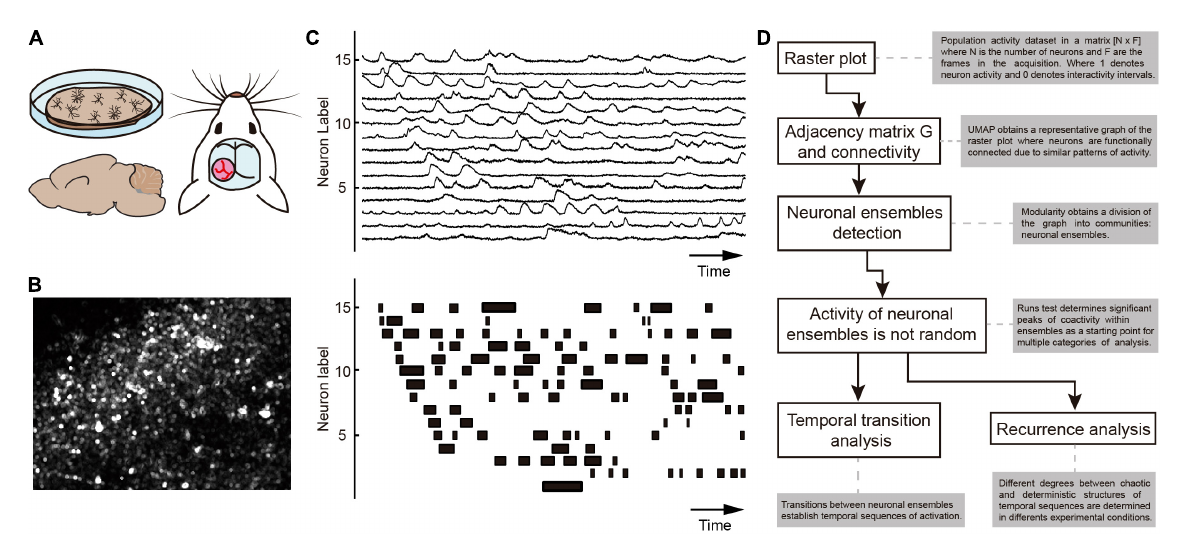
FIGURE2 Analysis of calcium imaging experiments. (A) Calcium imaging movies can be acquired from neuron cultures (top left), brain slices (bottom left) or in vivo (right). With the aid of a molecule that fluoresces by binding calcium flowing into the activated neurons, the objective is to examine neurons that are present in the field of view. (B) An illustration of a video frame taken in a region of the brain where the fluorescent protein GCaMP6f is expressed in the cells. Regions of interest (ROI) are created from image sequences like this one to collect calcium signals. (C) Top: An illustration of calcium signals extracted from ROIs. Graphed as a raster plot at the bottom, neuronal activity inferred from calcium signals where each row represents the activity of a single neuron. Several techniques exist for creating raster plots from neural activity (Theis et al., 2016). (D) Once a raster plot has been created, an analysis pipeline is proposed and further described in the present